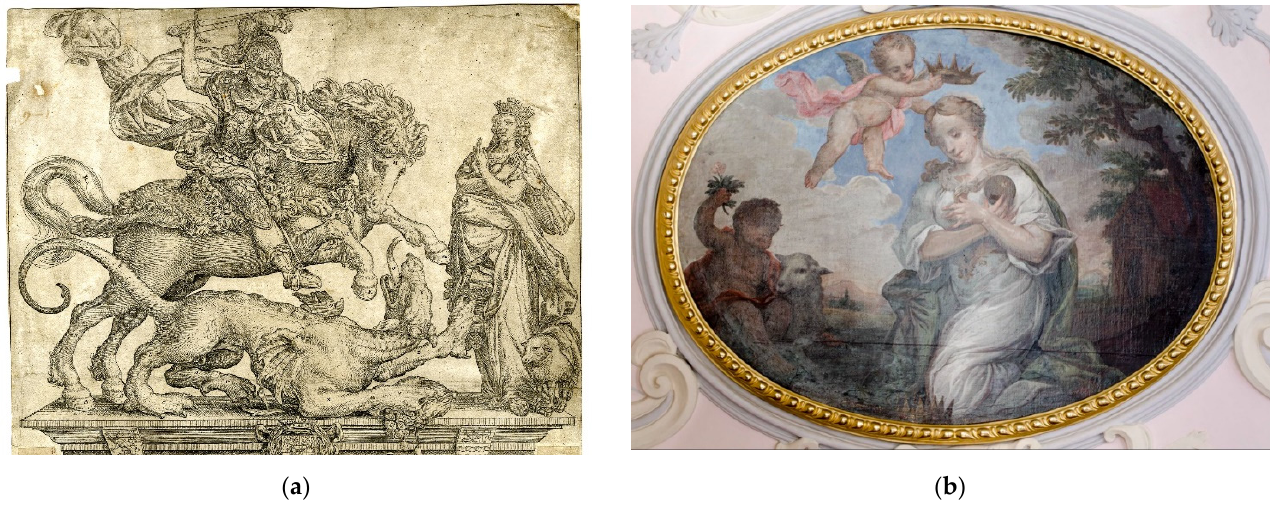
Figure 12. ( a ) Virtue against Vice and Humility, c. 1535–1590, London, British Museum; ( b ) Allegory of Humility, Marcantonio Franceschini, 1715, Heiligenkreuz, Stift Heiligenkreuz.